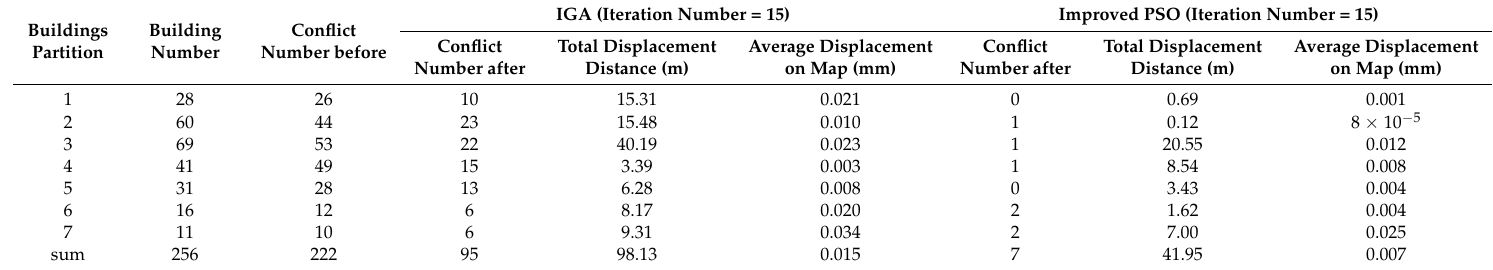
Table 2. Displacement results after 15 iterations.